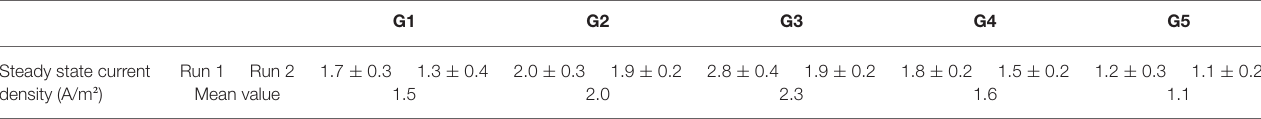
TABLE 4 | Steady state current densities and maximal current densities obtained with the 5 grades of